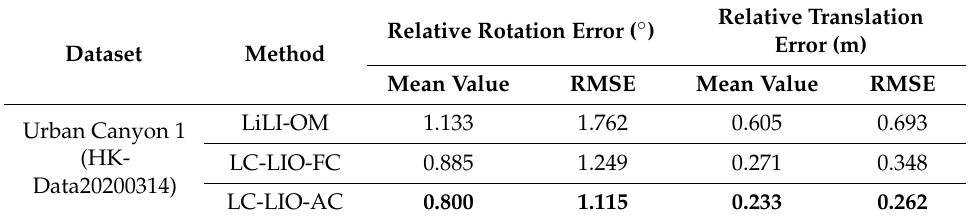
Table 1. RPE of LiLi-OM, LC-LIO-FC and LC-LIO-AC produced by EVO [40] in the urban canyon 1. The bold values represents best